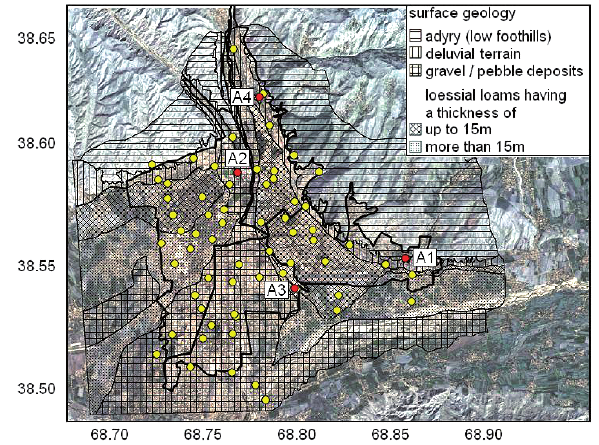
Figure 5. Surface soils [Zodotarow et al., undated] for the city of Dushanbe. Yellow dots represent installation sites of the temporary seismic network. Red dots represent array measurement sites and black dots represent noise measurement sites. Network installation sites and sites of array measurements mentioned in the text are la- beled. The thick black lines are administrative borders of the